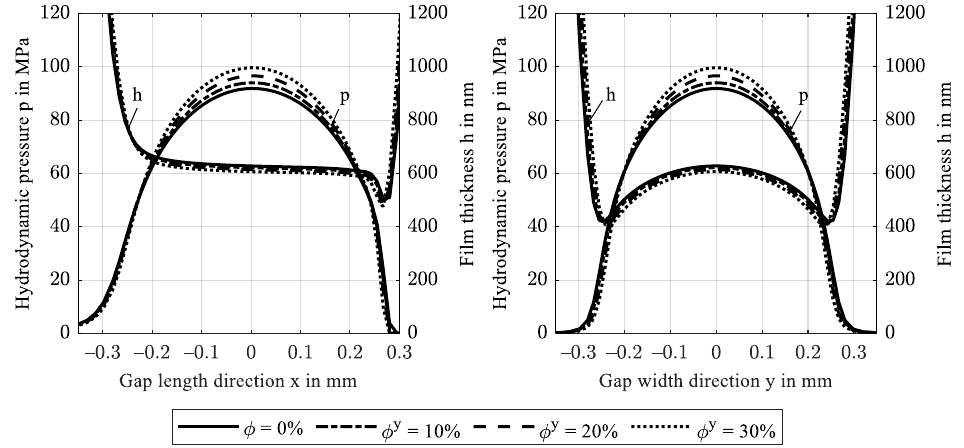
Figure 6. Hydrodynamic pressure p and film thickness profiles h along the gap length x at y = 0 ( left ) and along the gap width y at x = 0 ( right ) for increasing fiber content in the y-direction φ y .